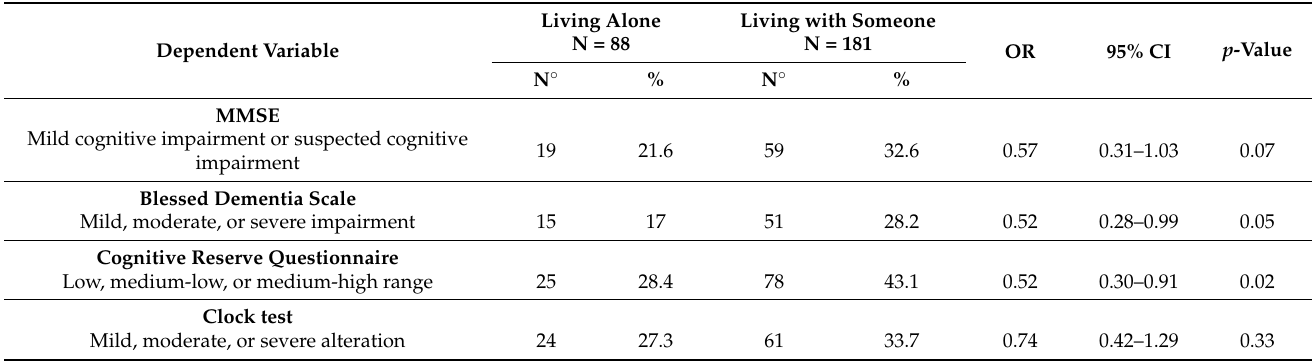
degree of cognitive impairment compared with a woman who lived with someone. Fur- thermore, living alone was also statistically associated with a lower probability of having a low, medium-low, or medium-high range of cognitive reserve (OR = 0.52, p = 0.02), namely, a 92% lower probability of displaying decreased cognitive reserve. The clock test did not yield statistical significance (see Table 2). Table 2. Association between living alone, displaying cognitive impairment (MMSE and Blessed), and cognitive reserve. Living Alone Living with Someone Dependent Variable OR 95% CI p -ValueN = 88 N = 181 N ◦ % N ◦ % MMSE Mild cognitive impairment or suspected cognitive 19 21.6 59 32.6 0.57 0.07 impairment